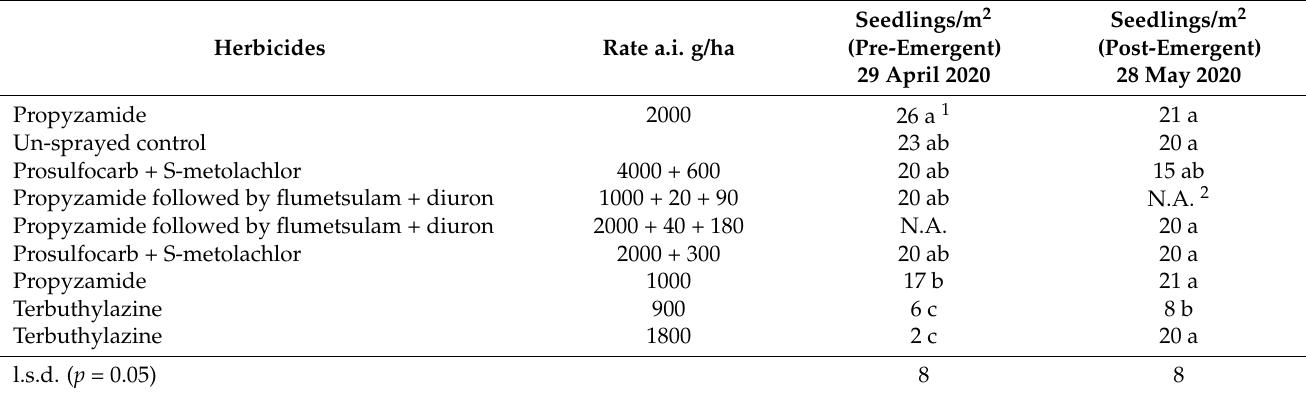
Table 9. Number of tedera seedlings/m 2 one month after the application of pre- and post- emergent herbicides.